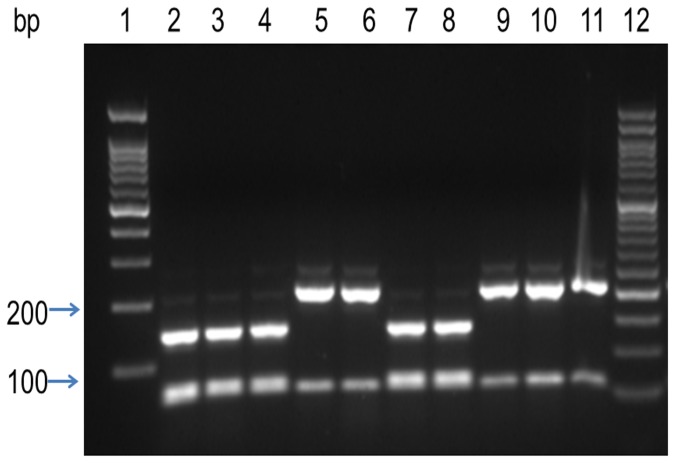
A representative DNA electrophoresis gel showing the RFLP patterns of the serotypes 6A/C and 6B after BsrI digestion of the amplified cps amplicon (273 bp) for isolates of S. pneumonia of the serogroup 6.DNA was visualized in 2% agarose gel: lane 1 100 bp ladder; lane 12 50 bp ladder. Lanes 2–4 and 7–8 S. pneumonia serotype 6A/C patterns (yielding fragments of 145, 69 and 59 bp, with both smaller fragments showing as one thick band owing to low separation). Lanes 5–6 and 9–11 S. pneumonia serotype 6B (yielding fragments of 214 and 59 bp).